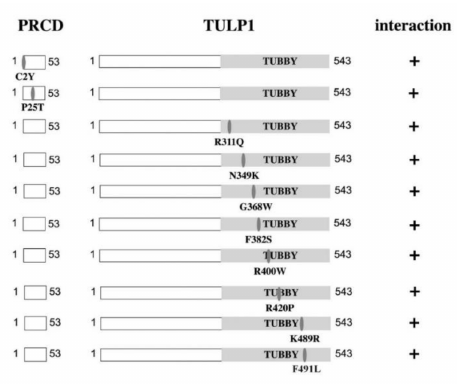
Figure 4. The e ff ect of mutations in PRCD and TULP1 on their interaction. Shown are schematic representations of the di ff erent PRCD and TULP1 mutated constructs tested. Each line represents a pull-down